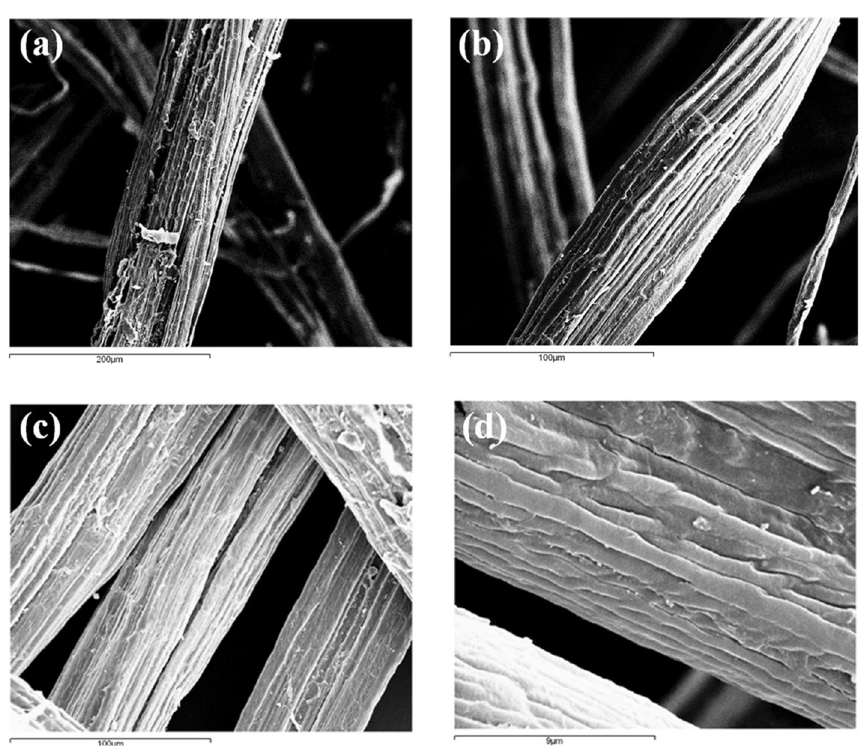
Figure 3. SEM microphotographs of the raw fiber ( a ) and of the fibers treated with the chemical softeners TTAB ( b ), LP ( c ), and LS ( d ).